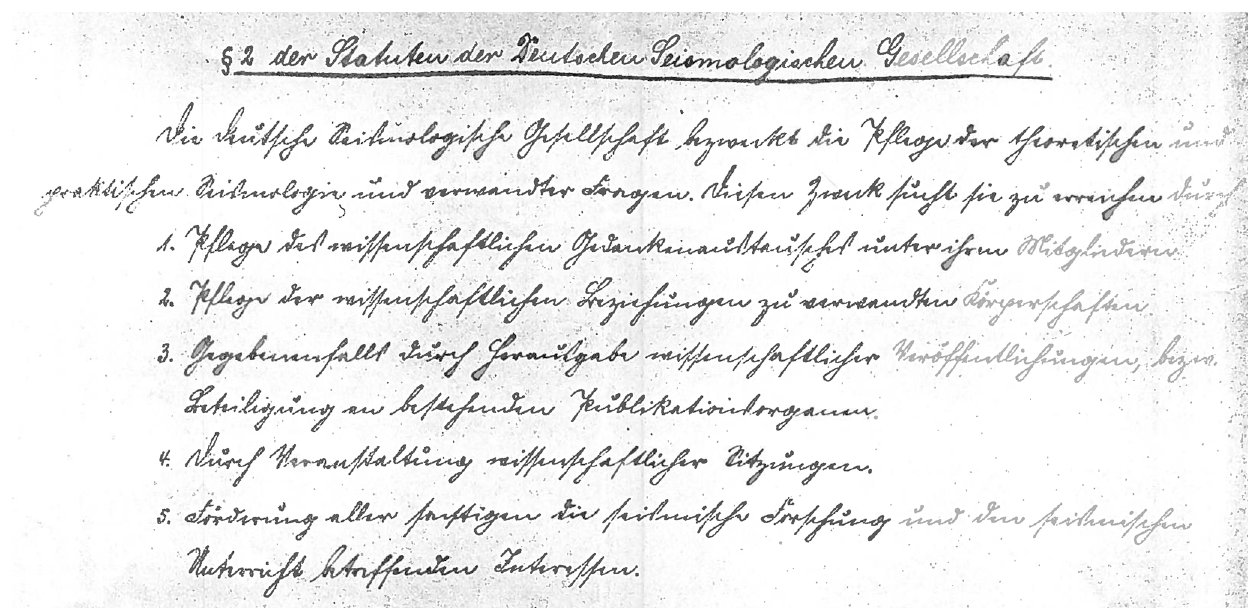
Figure 1. Facsimile of the attachment to Oskar August Ernst Hecker’s letter (Hecker, 1922) to Carl Wolfgang Lutz (1878–1946; Angenheis- ter, 1987) containing §2 of the DSG statutes, written in old German handwriting, as adopted on 21 September 1922. Table 1. DGG memberships during the first 10 years, regularly published as a separate list or as published in the DGG journal Zeitschrift für Geophysik (ZfG)